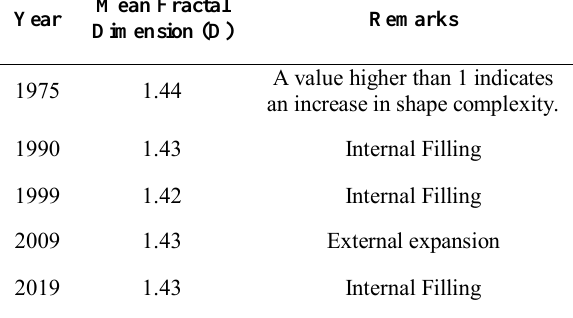
Table 3 . Mean Fractal Dimension of Vasai